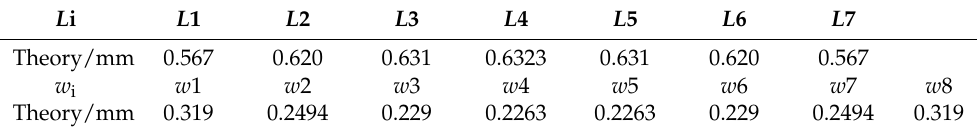
Table 1. Theoretical values of structural parameters of 340 GHz filter.